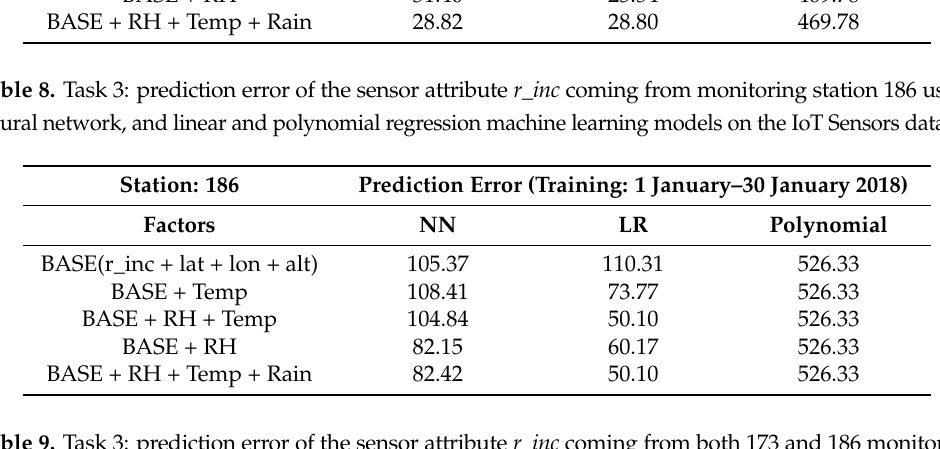
Table 9. Task 3: prediction error of the sensor attribute r_inc coming from both 173 and 186 monitoring station using neural network, and linear and polynomial regression machine learning models on the IoT Sensors